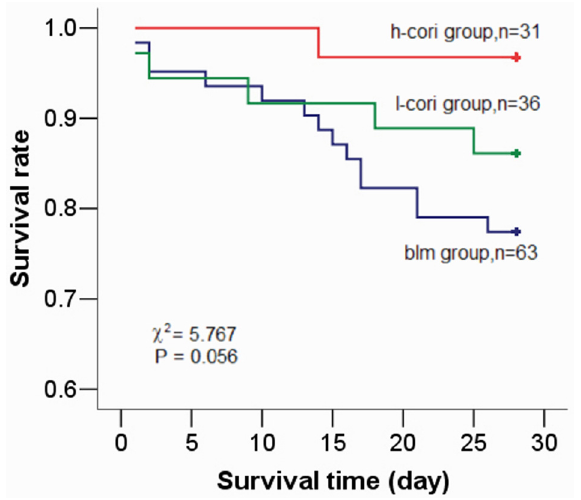
Figure 2. Kaplan-Meier survival curve of the mice after bleomycin treatment. There was no significant difference among survival in bleomycin exposure group (blm), bleomycin exposure and 10 mg/kg corilagin group (l-cori) and bleomycin exposure and 100 mg/kg